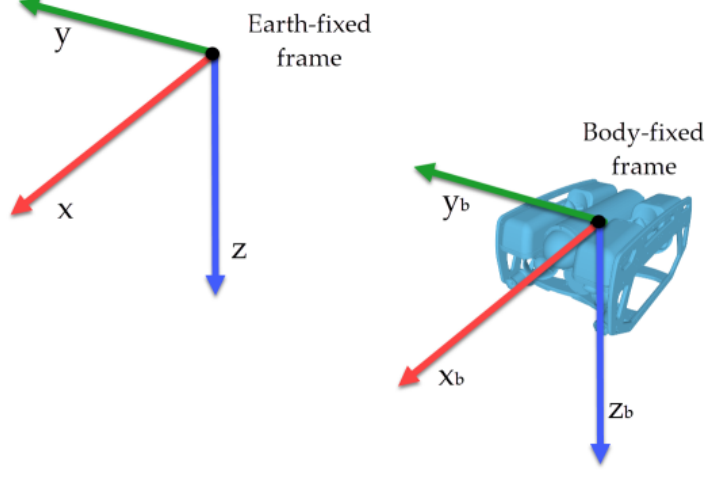
Figure 1. Reference frames for underwater vehicles.